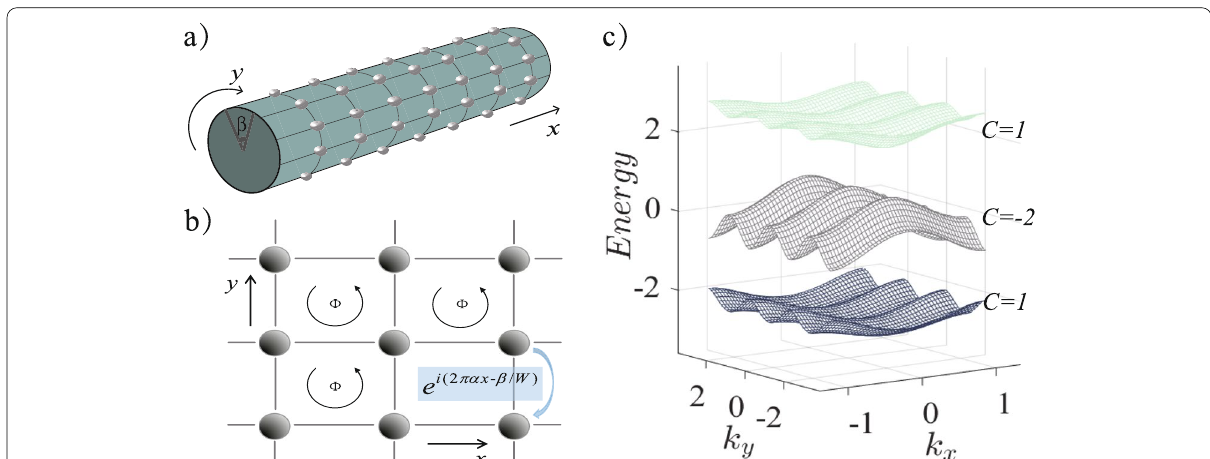
Fig. 1 Nearest‑neighbor hopping of atoms in a square lattice with a uniform magnetic field. a Nearest‑neighbor hopping on a two‑dimensional square lattice with the periodic boundary conditions along the y ‑direction. b A partial view of the system. c The energy bands of the Harper‑Hofstader model in momentum space, where the Chern numbers of three bands are 1, − 2,1 . The parameters are N = 30 , a x = a y = t = 1 , W = 9 , and β = 0.2